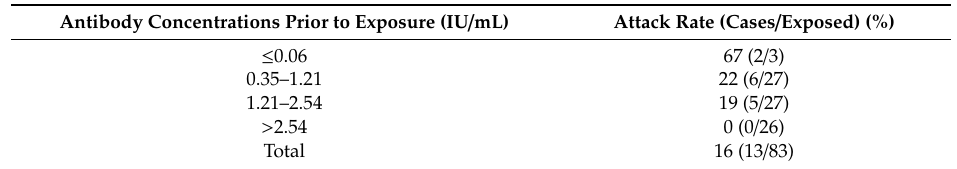
Figure 3. Receiver operator characteristic of the predictive value of measles neutralizing antibody concentrations measured prior to the measles outbreak in the Netherlands, 2013–2014, to protect against MV infection. The green dot corresponds with antibody levels of 1.71 IU / mL and yields the highest sum of the sensitivity and specificity. The AUC is 0.76 (95% CI: 0.65–0.88). Table 2. Attack rates of MV infection among participants (excluding those with evidence of MV infection prior to follow-up ( n = 8)) stratified by pre-exposure neutralization antibody concentration ( n = 83) during a measles outbreak in the Netherlands,